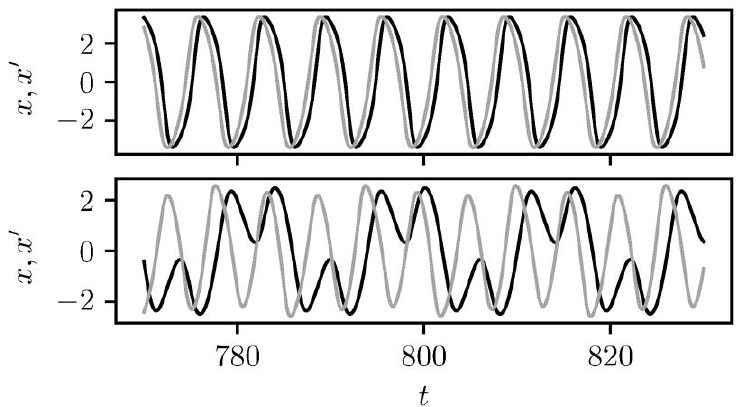
Figure 4. Right (black curve) and left (gray curve) oscillations in the 1:1 (top) and 3:3 synchronization regimes [18].